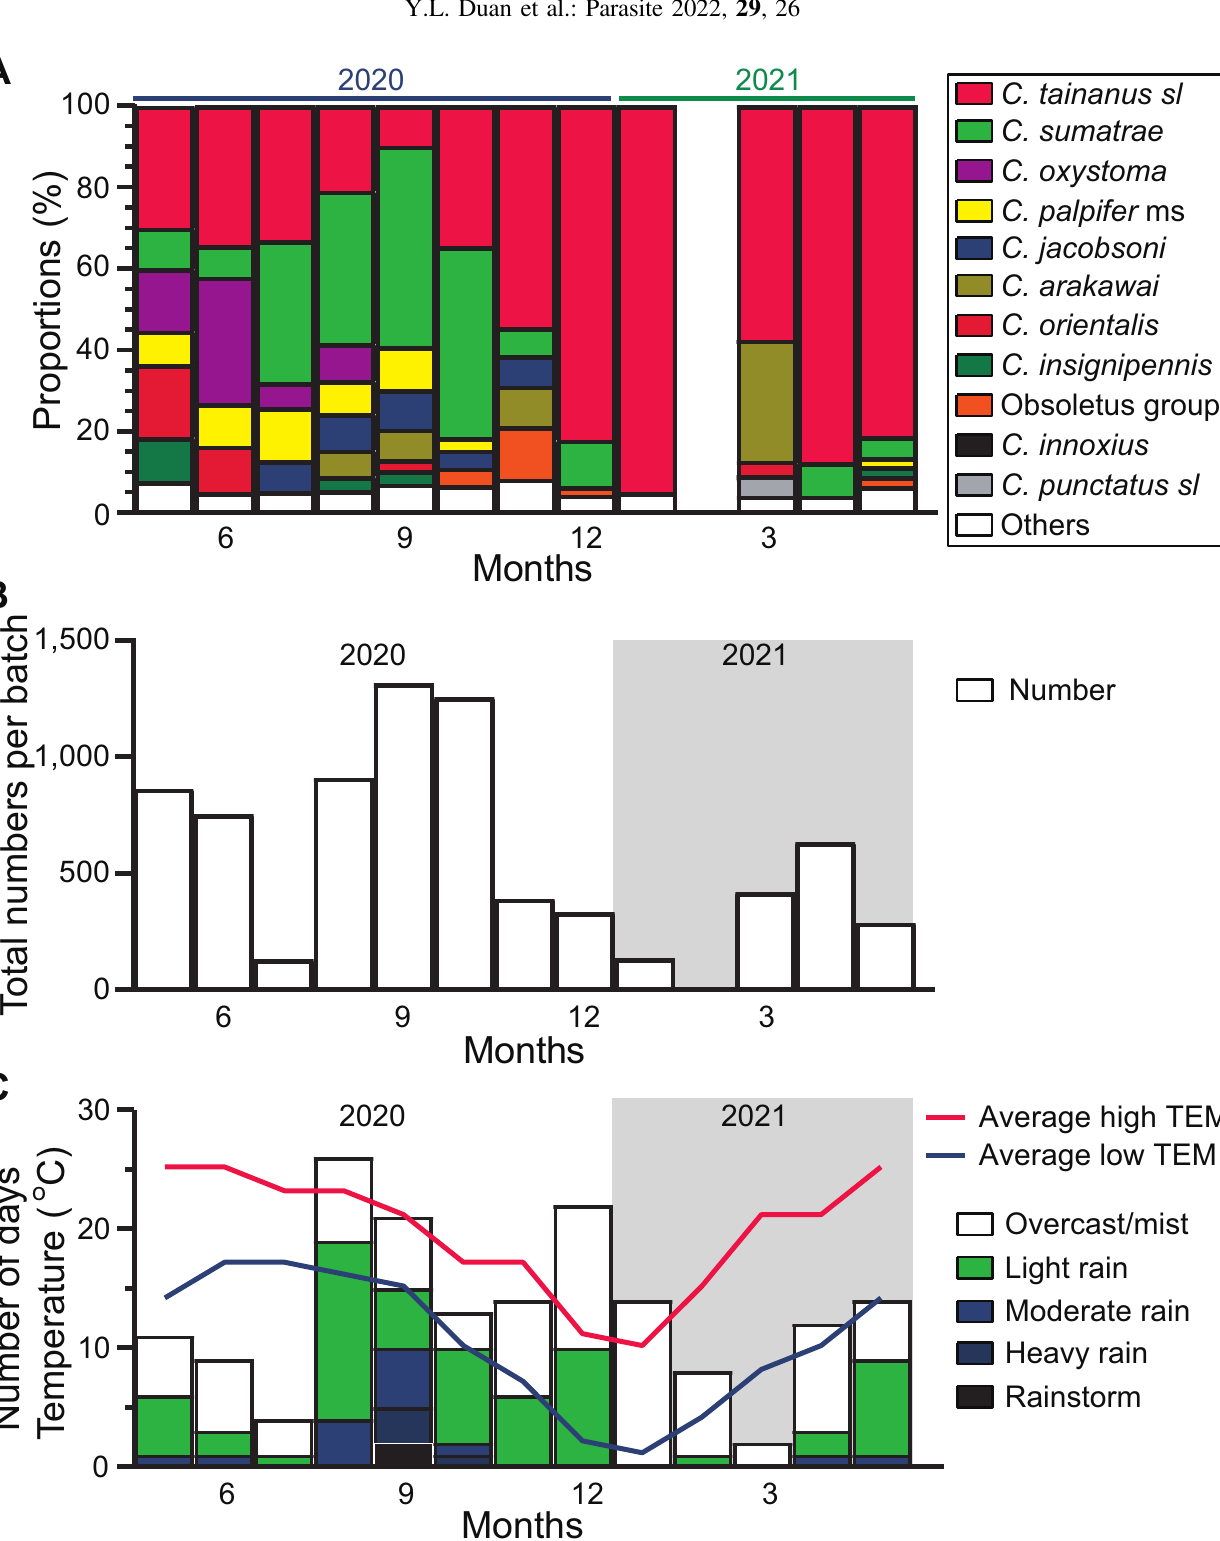
Figure 4. Seasonal abundance of Culicoides . A) Relative monthly abundance of Culicoides at Wulong, Shizong County, Yunnan Province, China between May 2020 and May 2021. Note that no trapping was done between 15 Jan and 20 Mar 2021; B) average Culicoides amount of each batch of collection every month; and C) average monthly maximum temperatures (TEM, red line) and minimum temperatures (blue line) and the number of the days per month experiencing one of the fi ve precipitation categories. The period in 2021 is highlighted in a grey